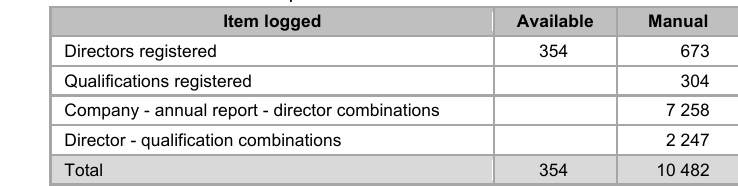
Data captured in the research